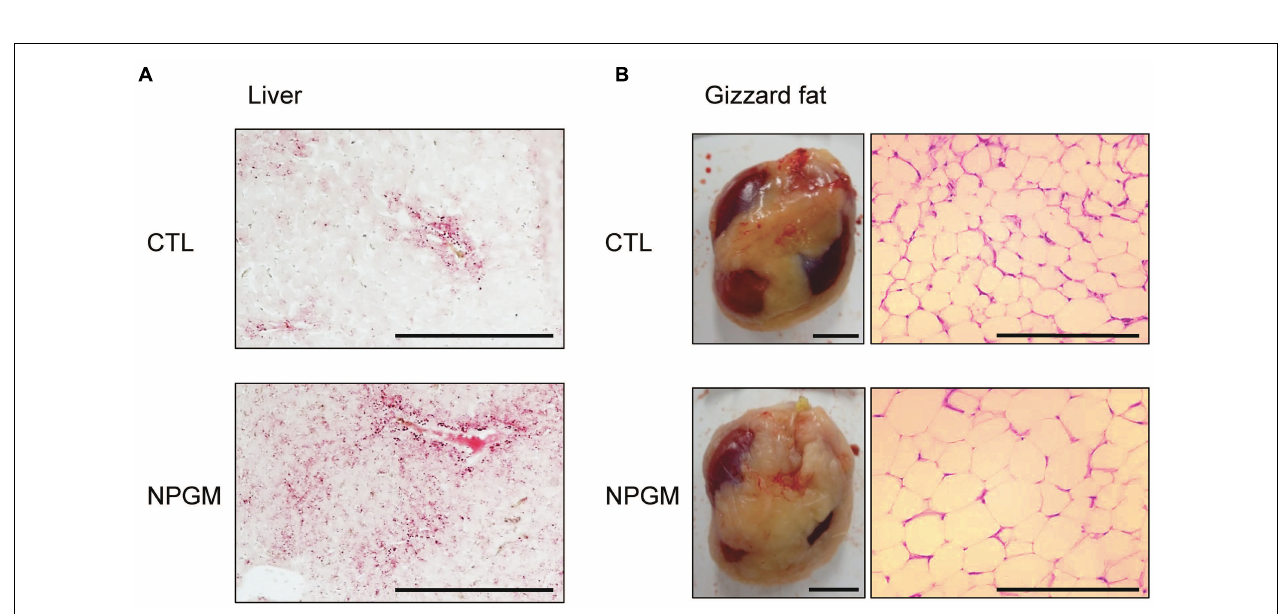
FIGURE 3 | Effect of chronic i.c.v. infusion of NPGM on lipid deposition in the liver and lipid droplets in the gizzard fat. The results were obtained 2 weeks after infusion of the vehicle (control; CTL) and NPGM. In the liver, representative photomicrographs of the sections were stained by Oil Red O (scale bar = 100 µ m) (A) . For the gizzard fat, exterior photographs around the gizzard (left panel, scale bar = 1 cm) and representative photographs of the sections stained by hematoxylin and eosin (right panel, scale bar = 100 µ m) (B) were obtained.